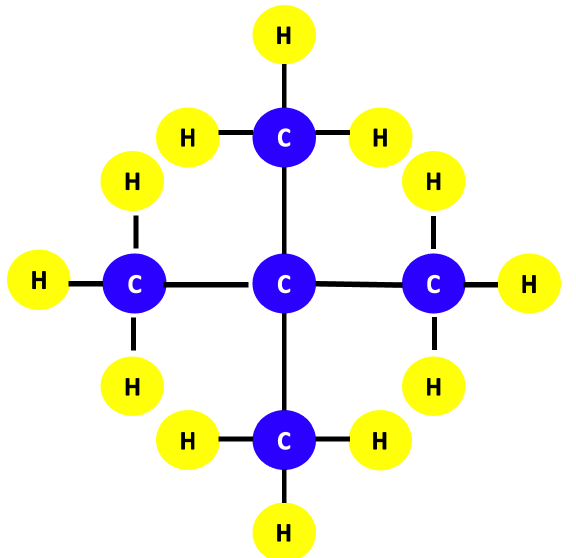
Figure 3. An illustration of a neopentane molecule C 5 H 12 framework. Furthermore, the methods used in [28,29] are insufficient since, as compared to the star graph, neopentane graphs have several junction points. As a robust approach, we use an alternative method in which we assign integer values (0 or 1) to the vertices and edge lengths | ˜ b τ | = 1 of the last graph (see Figure